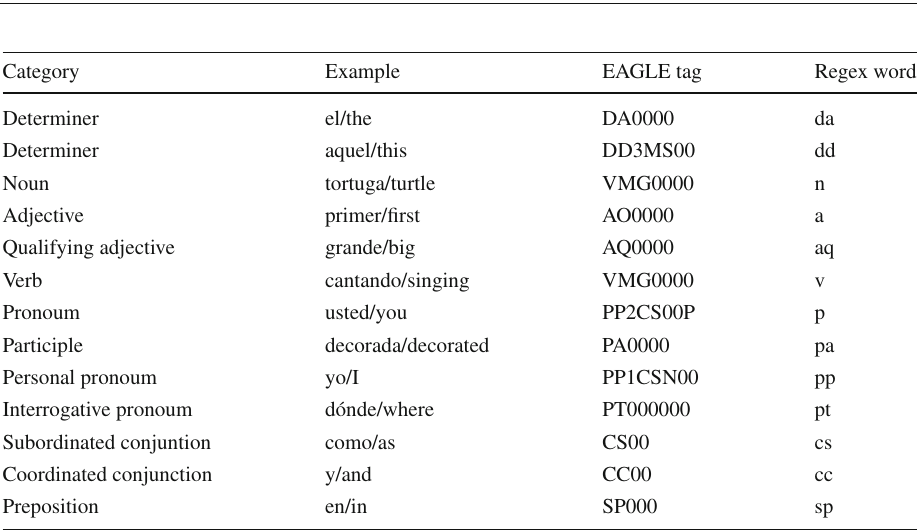
Table 3 Labels used in the pattern